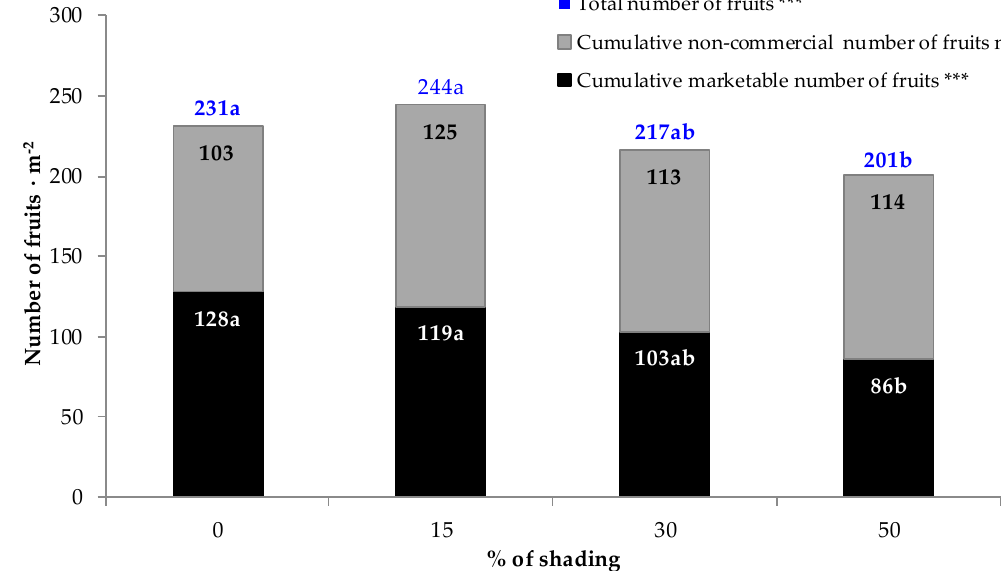
Figure 14. Shading e ff ect on the number of fruits (total, commercial and non-commercial) by m − 2 , harvested in the last harvesting period (239 d.a.t). Results comes from the analysis of the variance that is performed according to the Yij model = µ + α i + β j + ε ij. The nomenclature n.s., *, ** and *** indicates not significant or significant for p ≤ 0.05, 0.01 and 0.001, respectively. Numerical values for each column followed by di ff erent letters denote statistical significance for p < 0.05 according to the corrected minimum significant di ff erences (LSD) test.